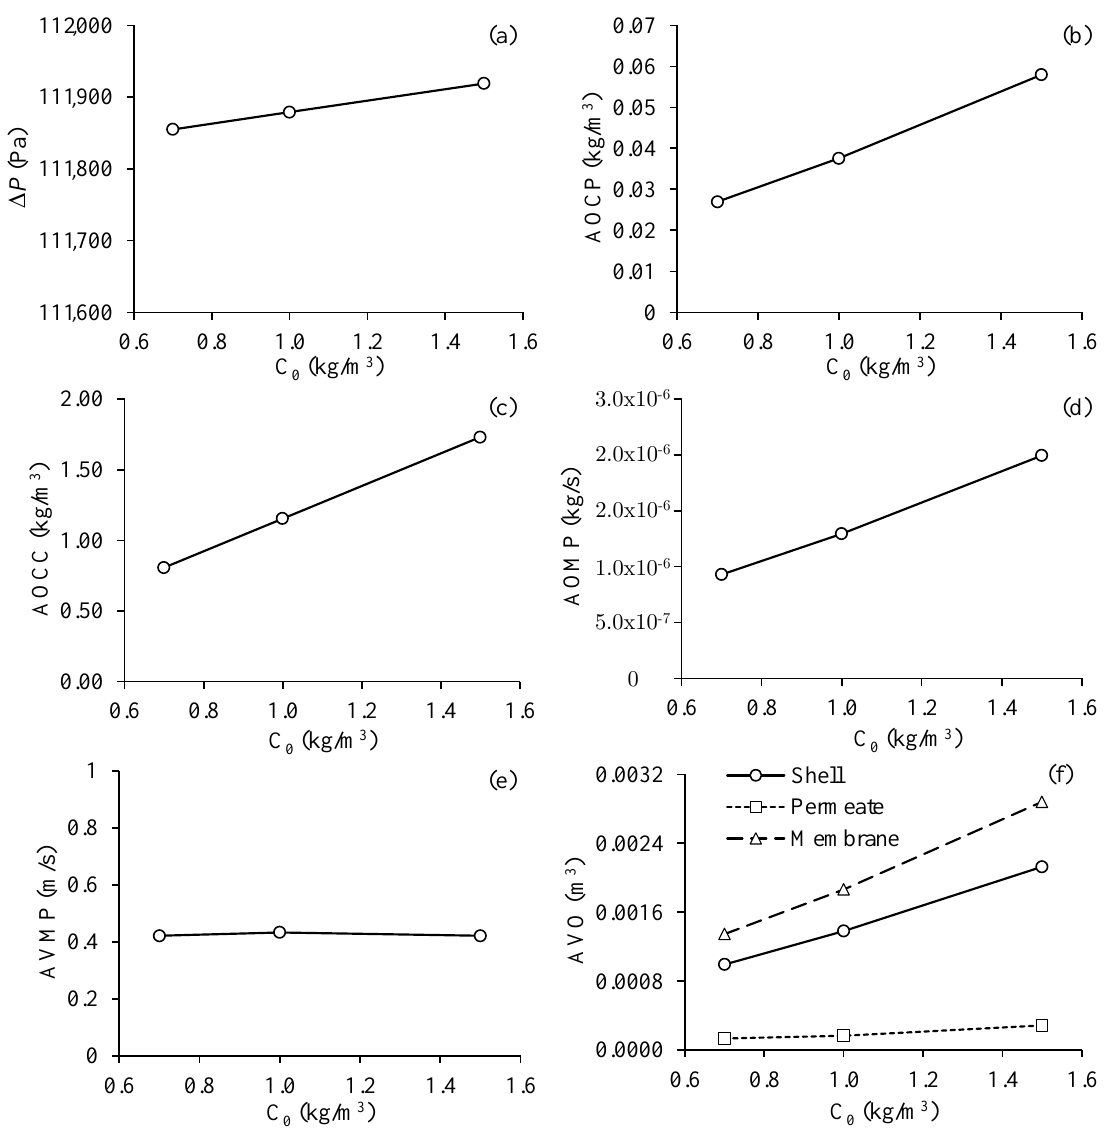
Figure 11. Process parameter in the filtration module as a function of the oil volumetric concentration in the feed. ( a ) Transmembrane pressure, ( b ) average oil volumetric concentration at the permeate outlets, ( c ) average oil volumetric concentration at the concentrate outlet, ( d ) average oil flow rate at the permeate outlets, ( e ) average fluid velocity in the permeate outlets and ( f ) average volume of oil present in the hull, membranes and permeate (Cases 5, 6 and 7).